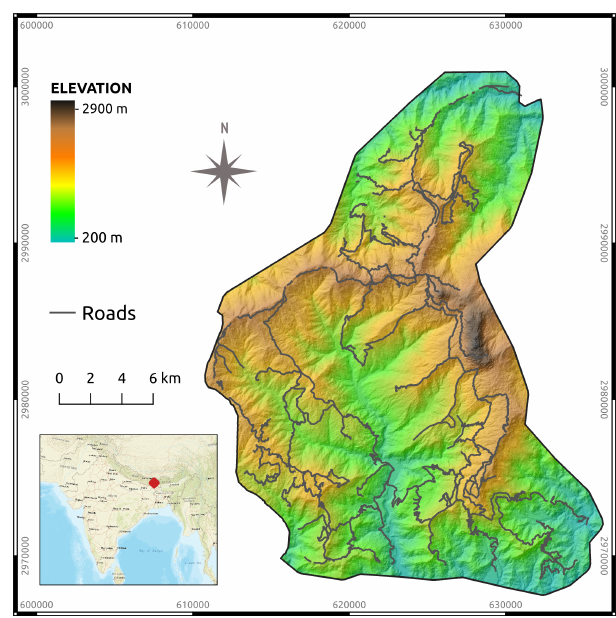
Figure 1. Location map of the Darjeeling district (India). Projec- tion: WGS 84/UTM zone 45N. Inset: location base map based on © OpenStreetMap contributors 2022. Distributed under the Open Data Commons Open Database License (ODbL)